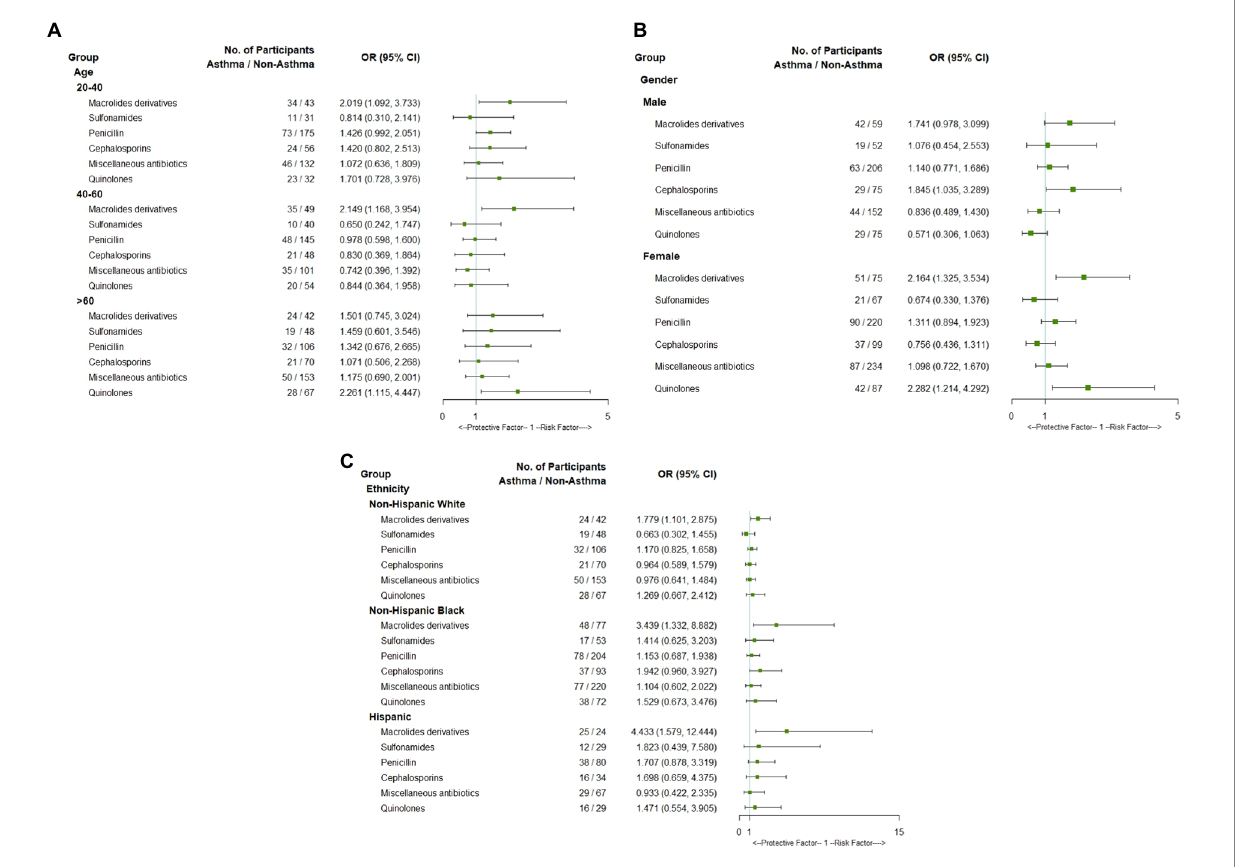
FIGURE 2 Forest plot of subgroup analysis of association between asthma and antibiotics use by age (A) , gender (B) and ethnicity (C)